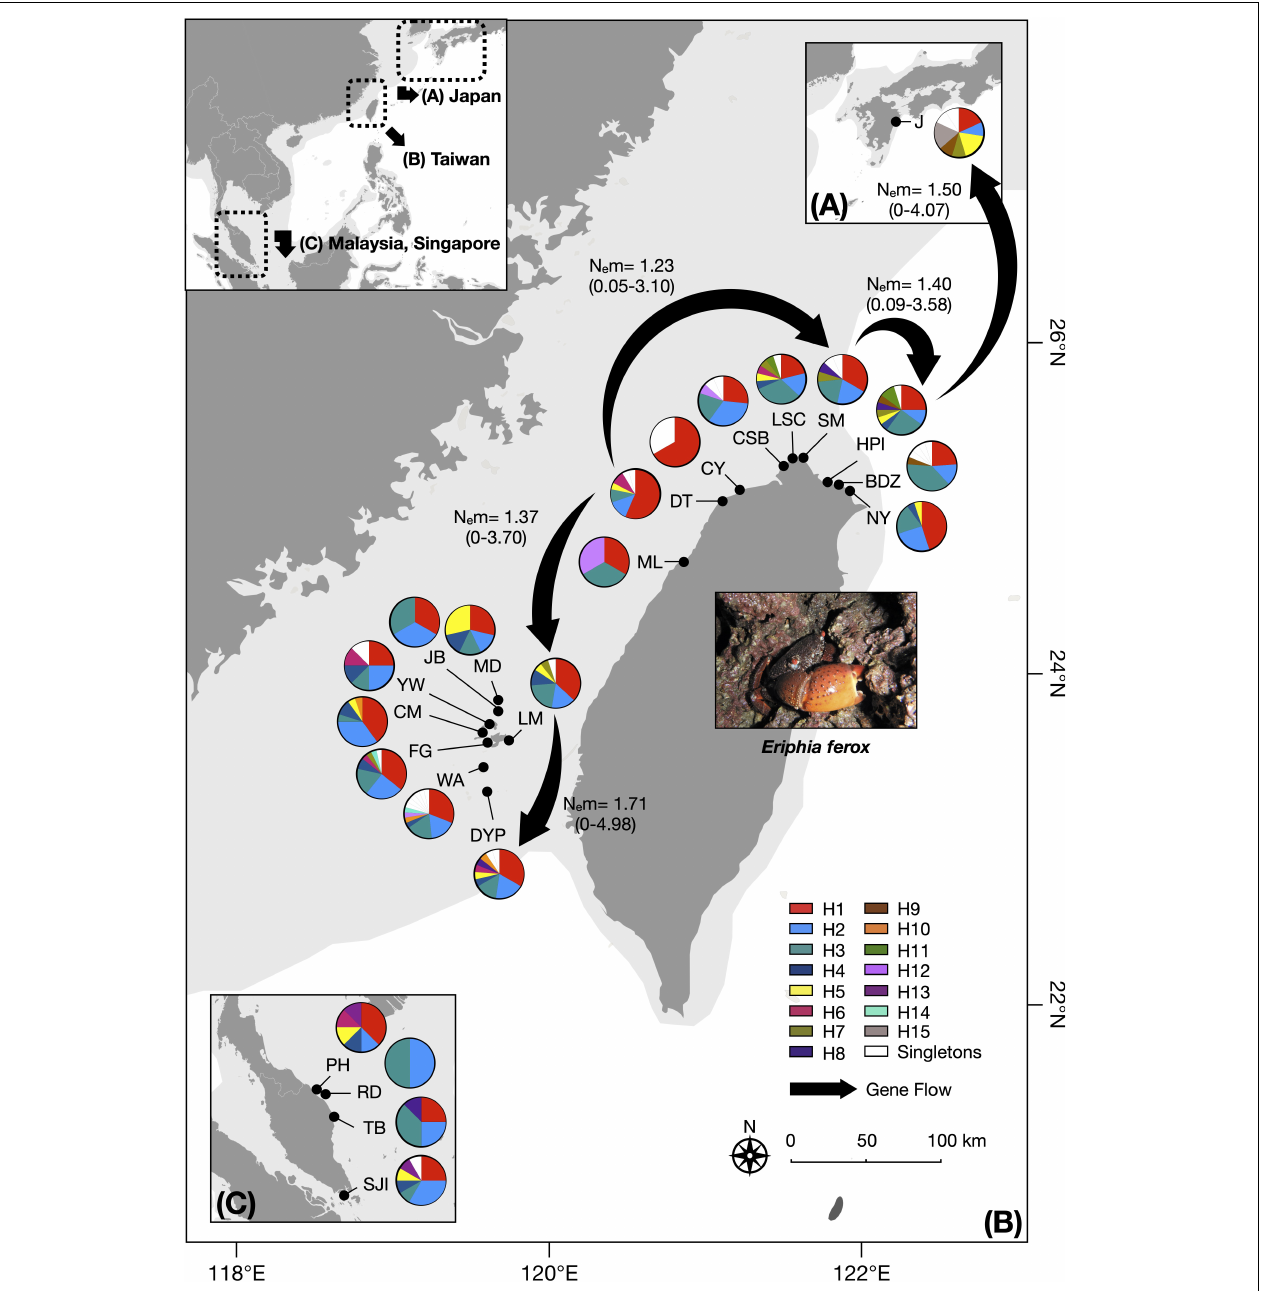
FIGURE 1 | Haplotype distribution and frequency map for Eriphia ferox in (A) Japan, (B) Taiwan, and (C) Malaysia and Singapore. Site abbreviations are listed in Table 1 . Different colors refer to different haplotypes. The landmass exposed during the Last Glacial Maximum (Ludt and Rocha, 2015) is shaded light gray. The directions of gene flow estimated between adjacent E. ferox populations are indicated with black arrows. Only six representative populations were examined (J: Japan; HPI: Hoping Island; SM: Shimen; DT: Datan; LM: Longmen; Dongyuping). Gene flows are presented by the effective number of migrants per generation (N e m), with 95% confidence intervals shown in